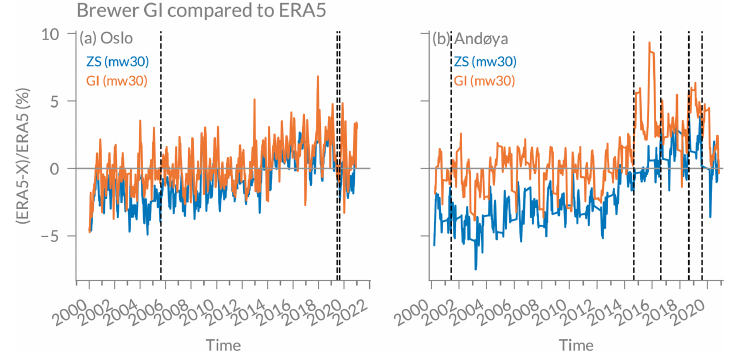
Figure A3. Brewer global irradiance (GI) data and Brewer zenith sky (ZS) data, both compared to ERA5 data at (a) Oslo and (b) Andøya. The time series have been smoothed with a moving mean window of 30d. Vertical dashed lines show dates that were used for GI calibration.